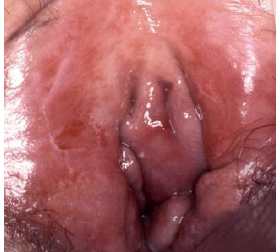
Figure 5. Lichen planus.